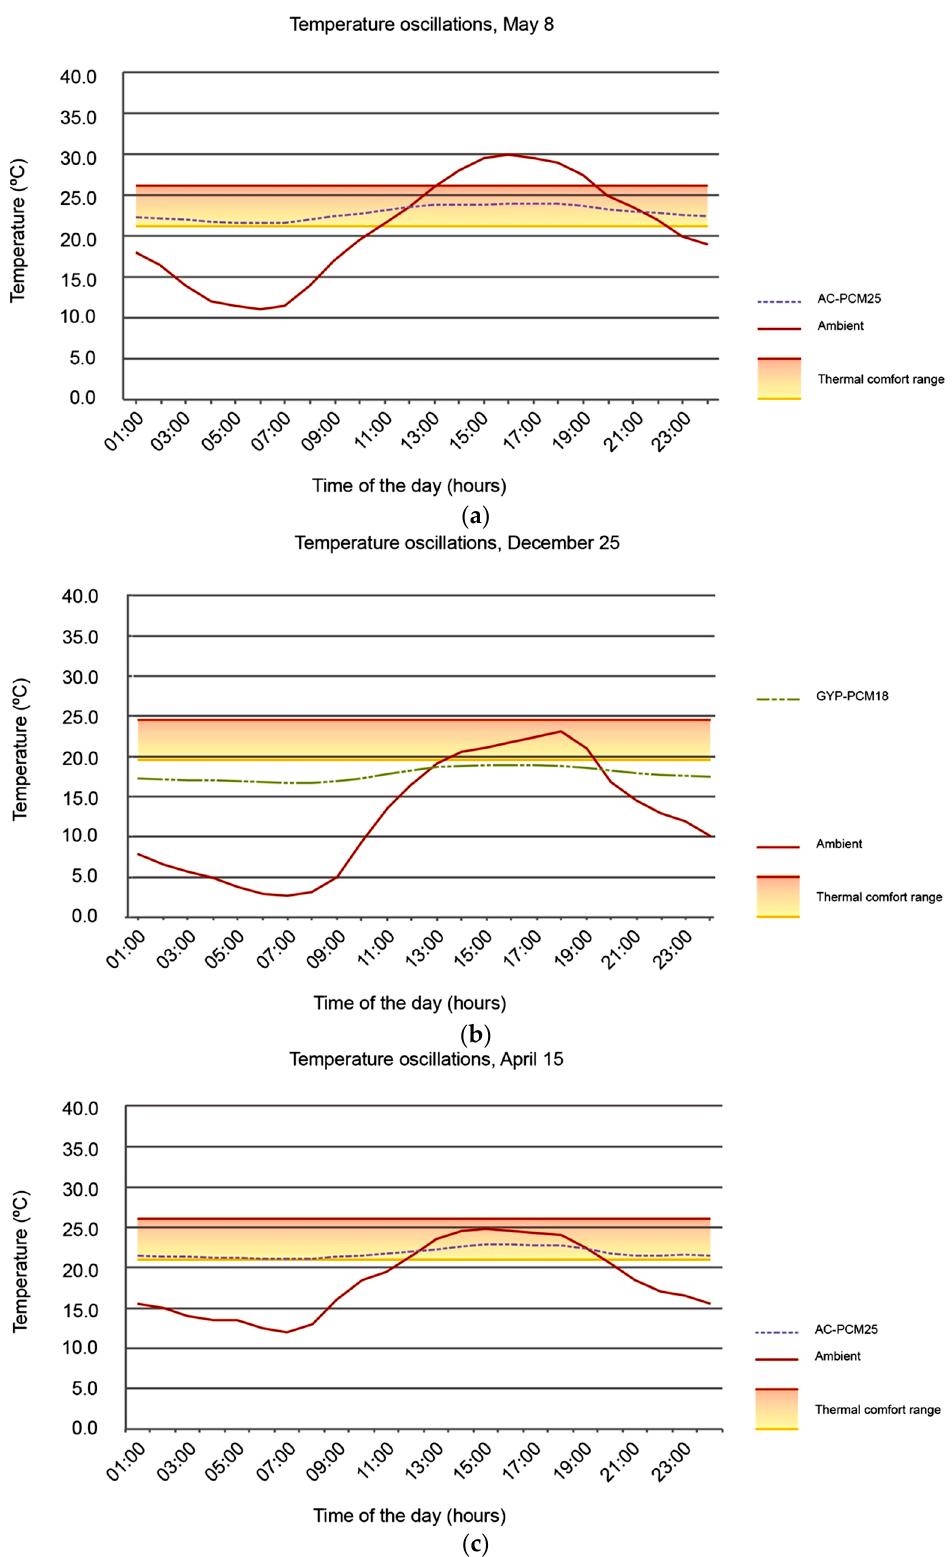
Figure 7. Indoor temperature oscillations corresponding to those case scenarios presenting best thermal performance during ( a ) 8 May, ( b ) 25 December, and ( c ) 15 April. performance during ( a ) 8 May, ( b ) 25 December, and ( c ) 15